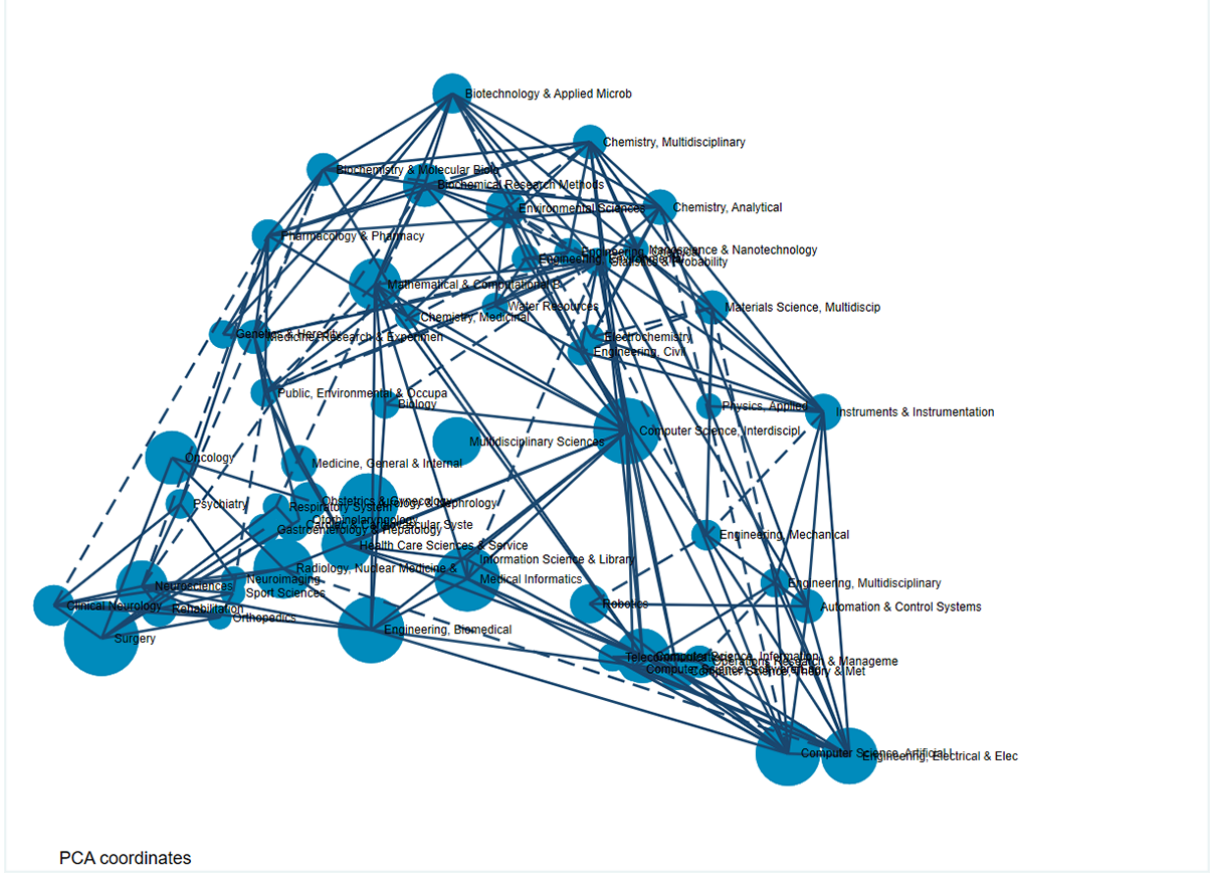
Figure 3. Landscapes of artificial intelligence in medicine by Web of Science categories. PCA: principal component analysis.